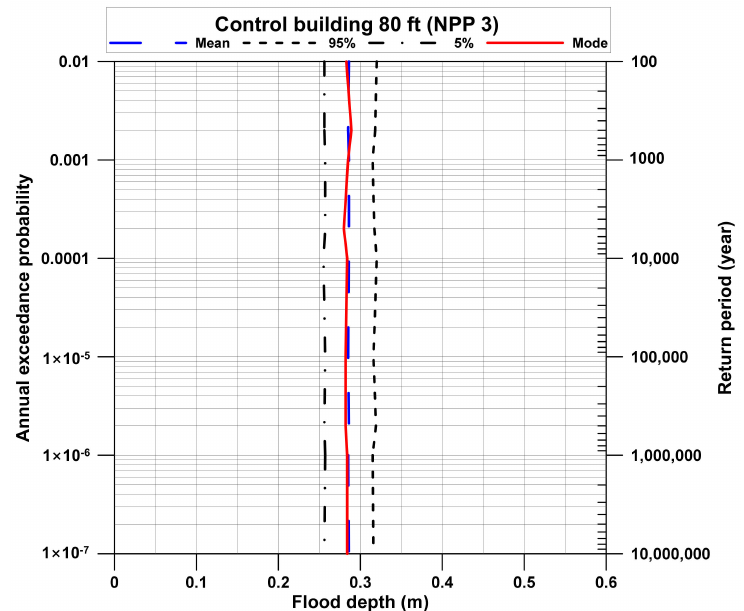
Figure 17. Probabilistic flood hazard curve for NPP 3.